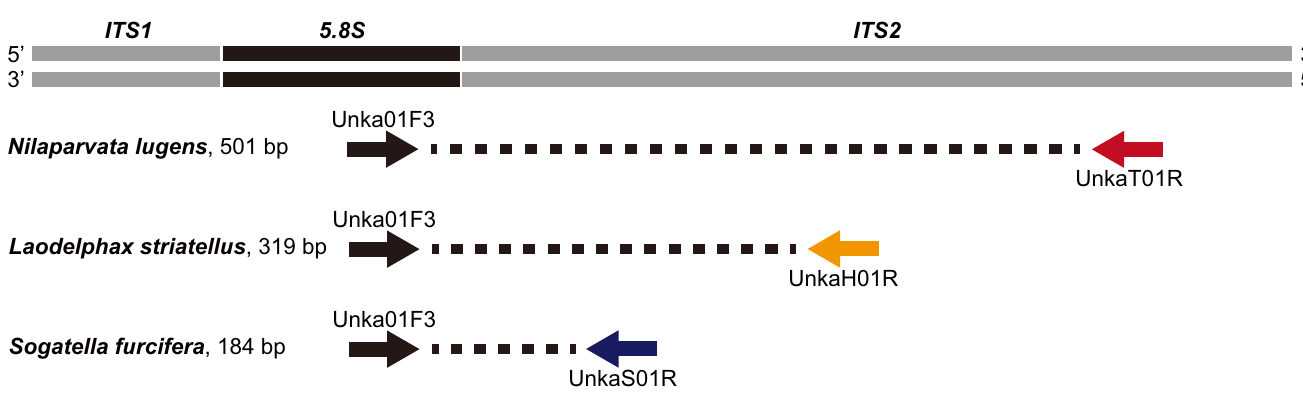
Fig 1. Schematic overview of conserved rice planthopper primers and species-specific primers targeting the partial 5 . 8S and ITS2 rDNA sequences, and corresponding PCR products allowing the identification of Nilaparvata lugens , Laodelphax striatellus , and Sogatella furcifera in a multiplex PCR. The primer sequences are listed in Table